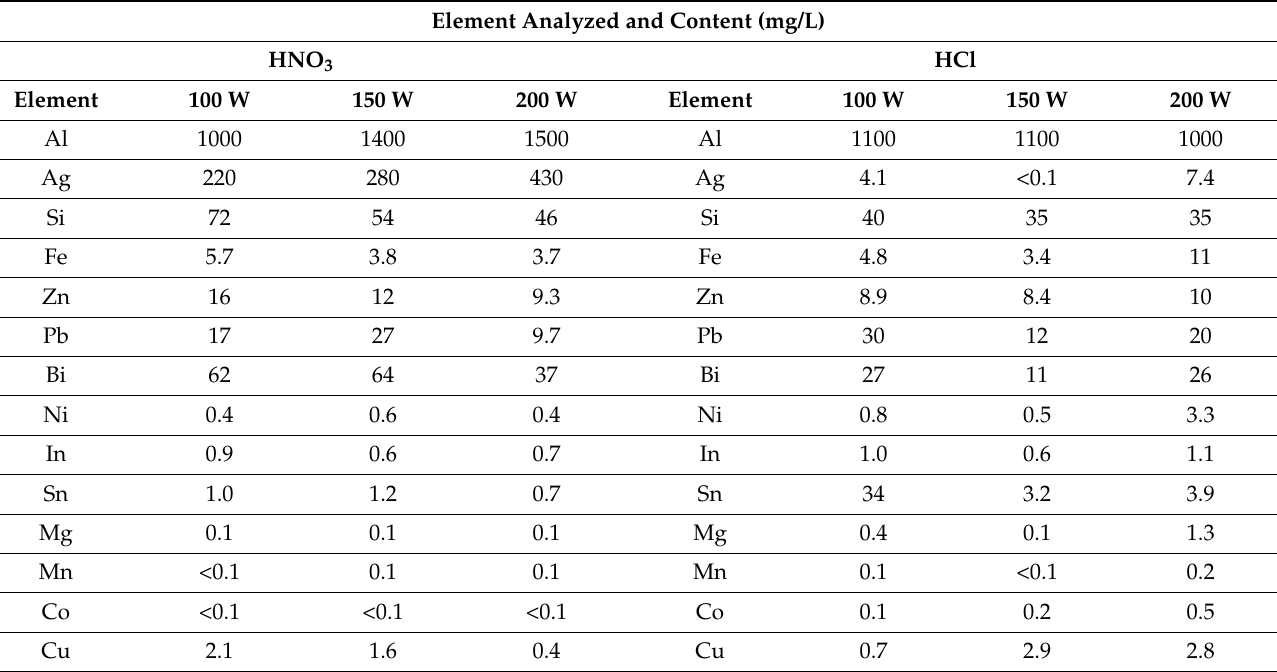
Table 11. ICP-Full Scan analysis results of the filtered solution—ultrasonic intensity.